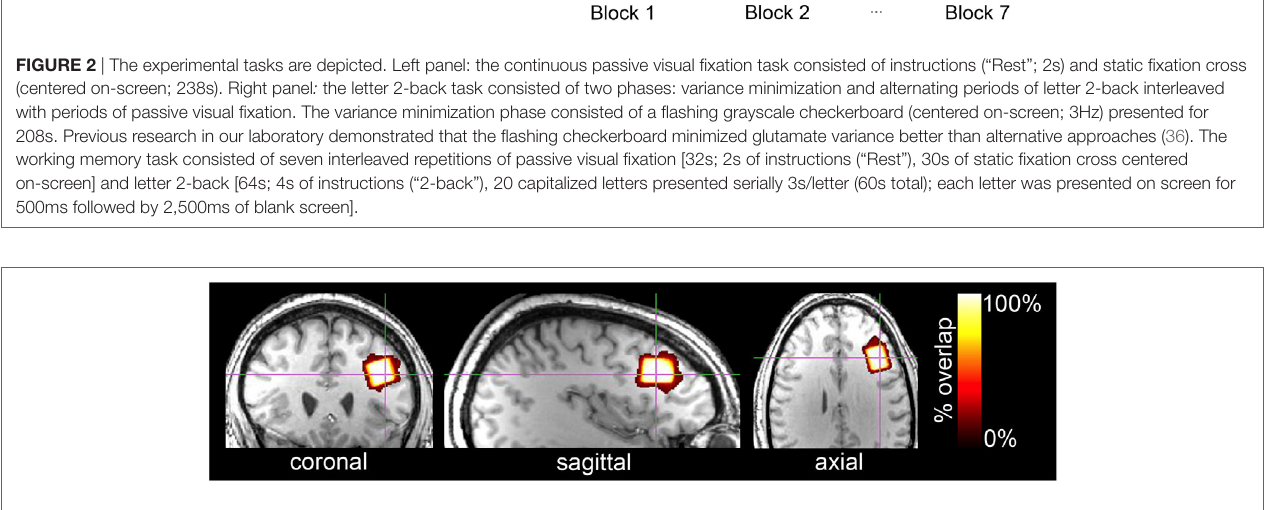
FigUre 3 | Orthonormal slices of voxel overlap across all subjects are depicted in a template brain. The voxel (15mm × 20mm × 15mm; 4.5cm 3 ) was located in the left dlPFC and included Brodmann areas 45 and 46. 3D geometric voxel overlap is indicated by the red-to-white color gradient (white = complete voxel overlap across all subjects; orange-red = incomplete overlap across subjects). Voxel placement reliability across all subjects was excellent